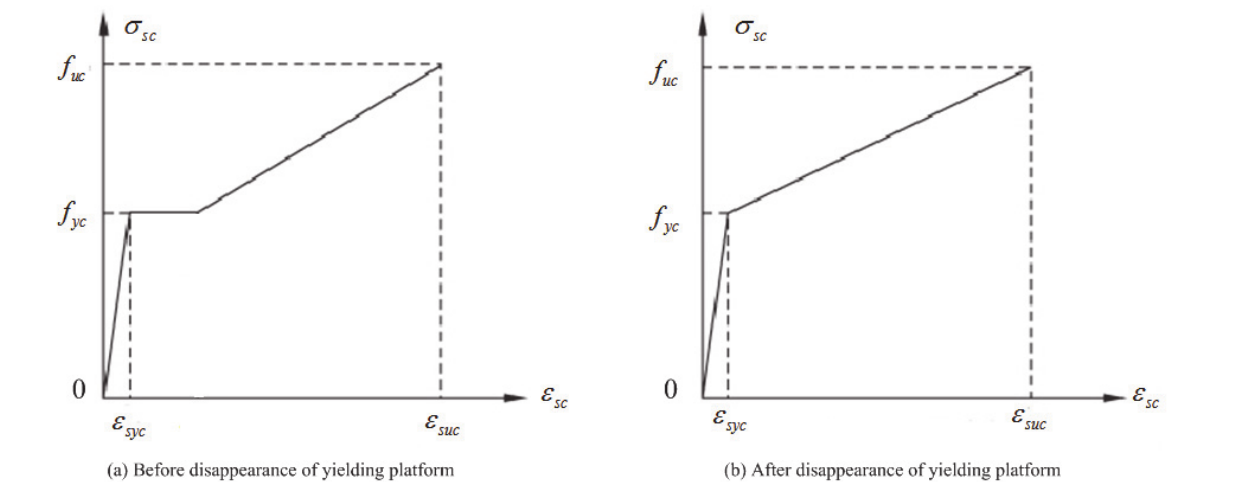
Figure 1: Constitutive relation curves for corroded steel reinforcement before and after disappearance of yielding platform [8]. Finite Element Model and Grid Generation